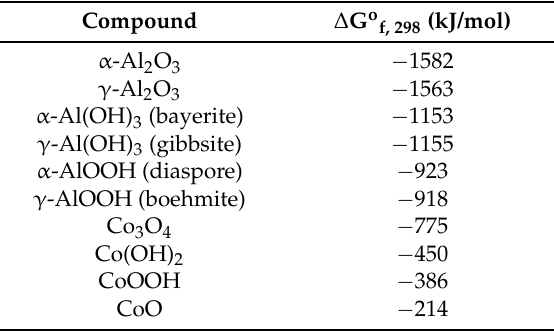
Table 5. Free energies of formation of compounds possibly included in the corrosion products of the Al-Co alloys